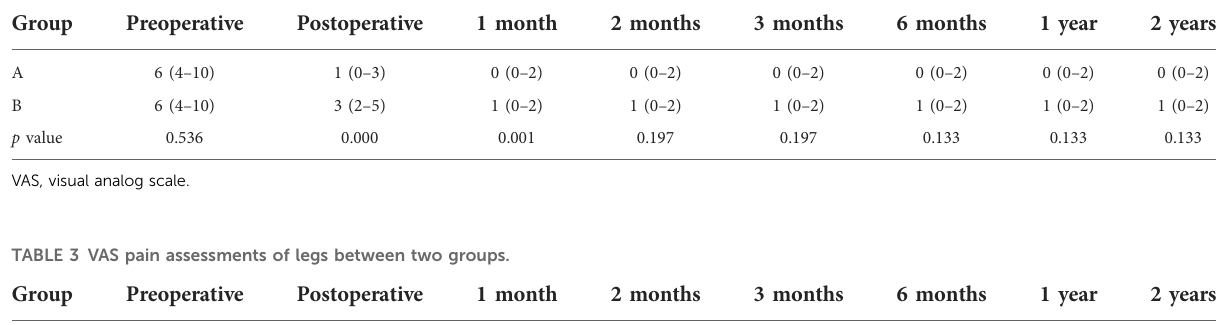
TABLE 2 VAS pain assessments of back between two groups.